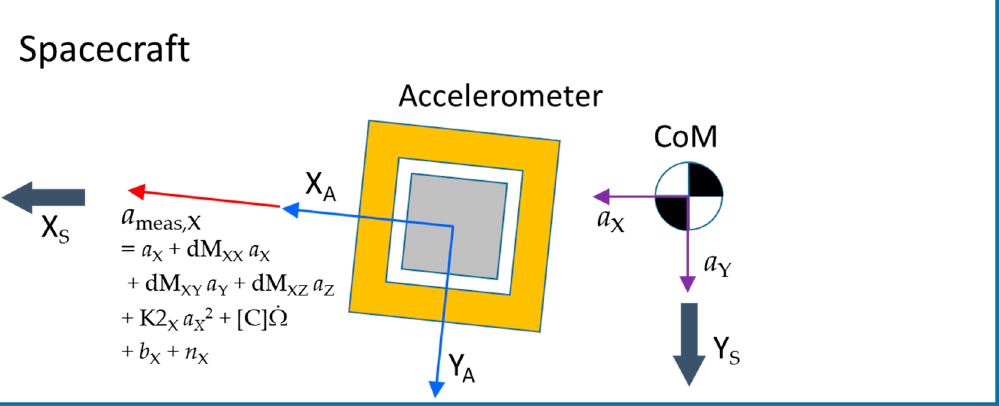
Figure 7. Illustration of the errors affecting a meas .